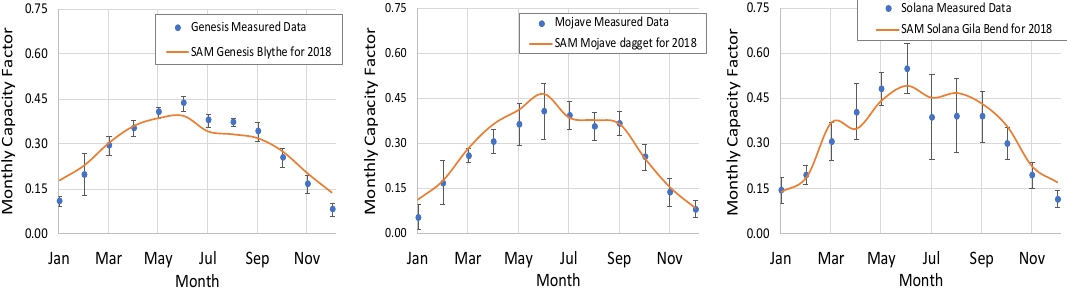
Figure 8. Statistical comparison of monthly capacity factors of measured and those extracted from SAM simulations for three different sites.